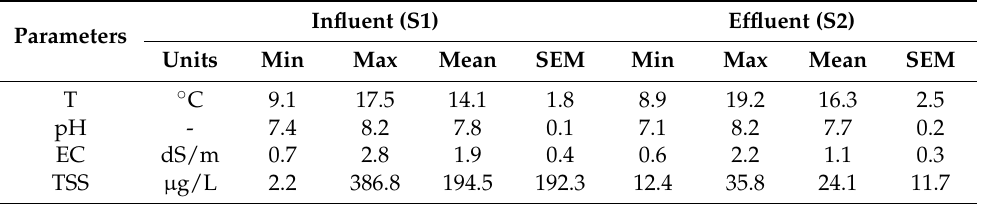
Table 2. Water quality indicators (mean and range) measured in influent (S1) and effluent (S2) surface water in the pilot site after its construction, from late summer to autumn